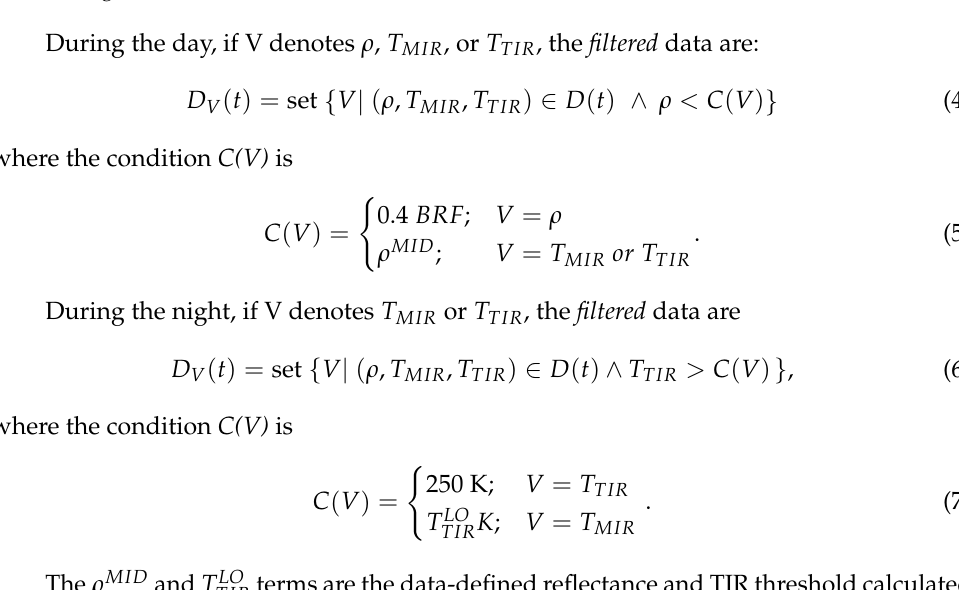
Figure 3. Schematic showing the determination of thresholds for the implementation of the modified BRIGHT algorithm.